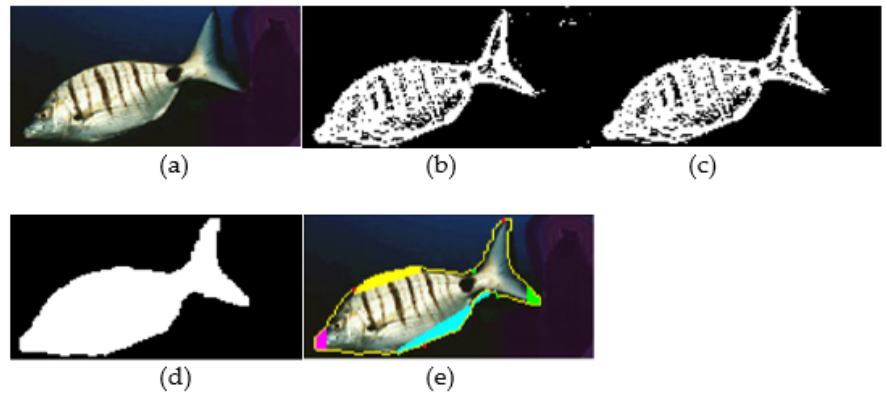
Figure 5. Processing of a photograph with the Contour1 path, showing the original image ( a ), after gradient edge detection ( b ), after edge reduction ( c ), after creating the solid fish body ( d ) and after coloring the fish regions ( e ).